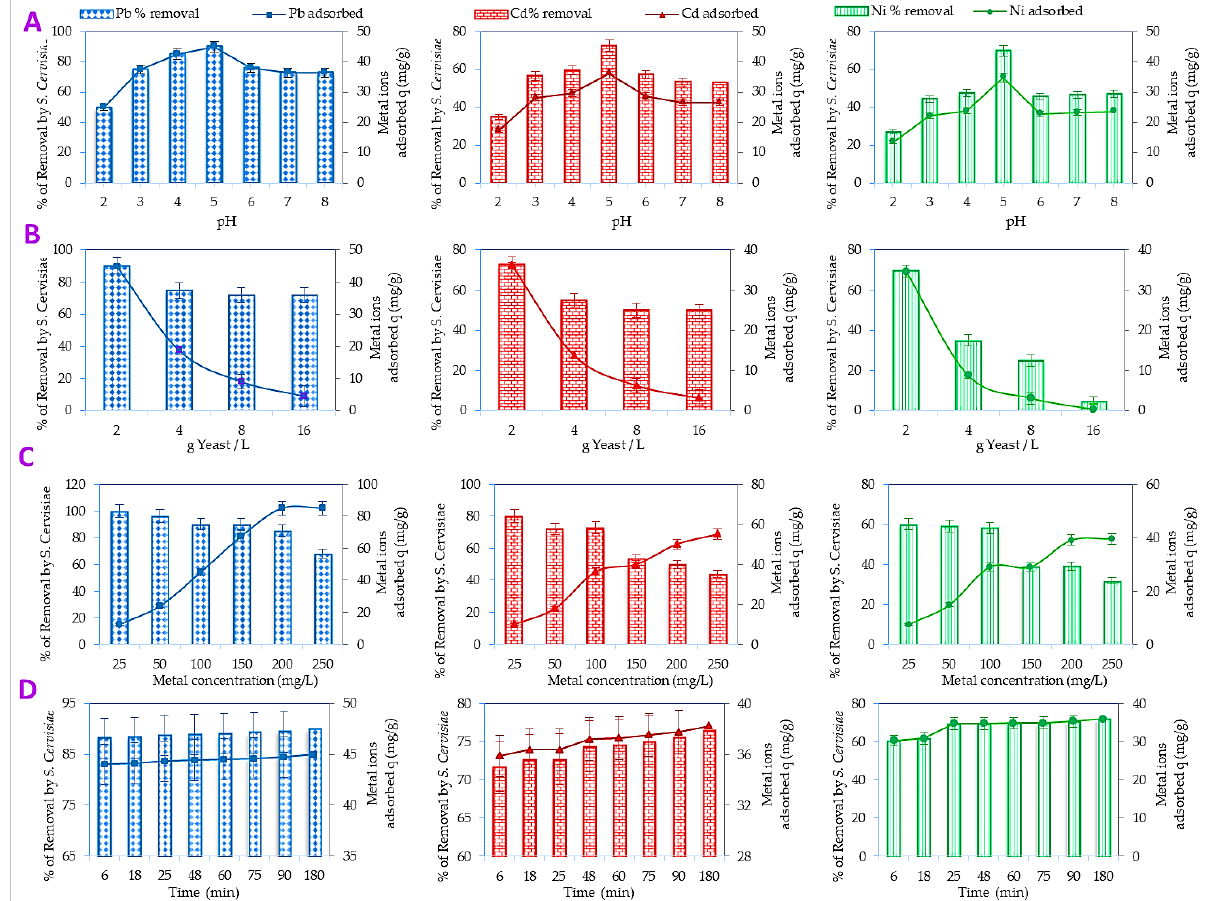
Figure 2. Impact of pH ( A ), biosorbent dose ( B ), initial concentration ( C ), and ( D ) time on the removal efficiency and adsorption capacity of Cd(II), Pb(II), and Ni(II) ions on S. cerevisiae yeast cells. For ( A , B , D ) the biosorbent concentration was 0.5 g/250 mL (dry mass/volume), and the initial metal concentration 100 mg/L, 25 °C, 150 rpm and 2 h. Error bars represent standard deviation.